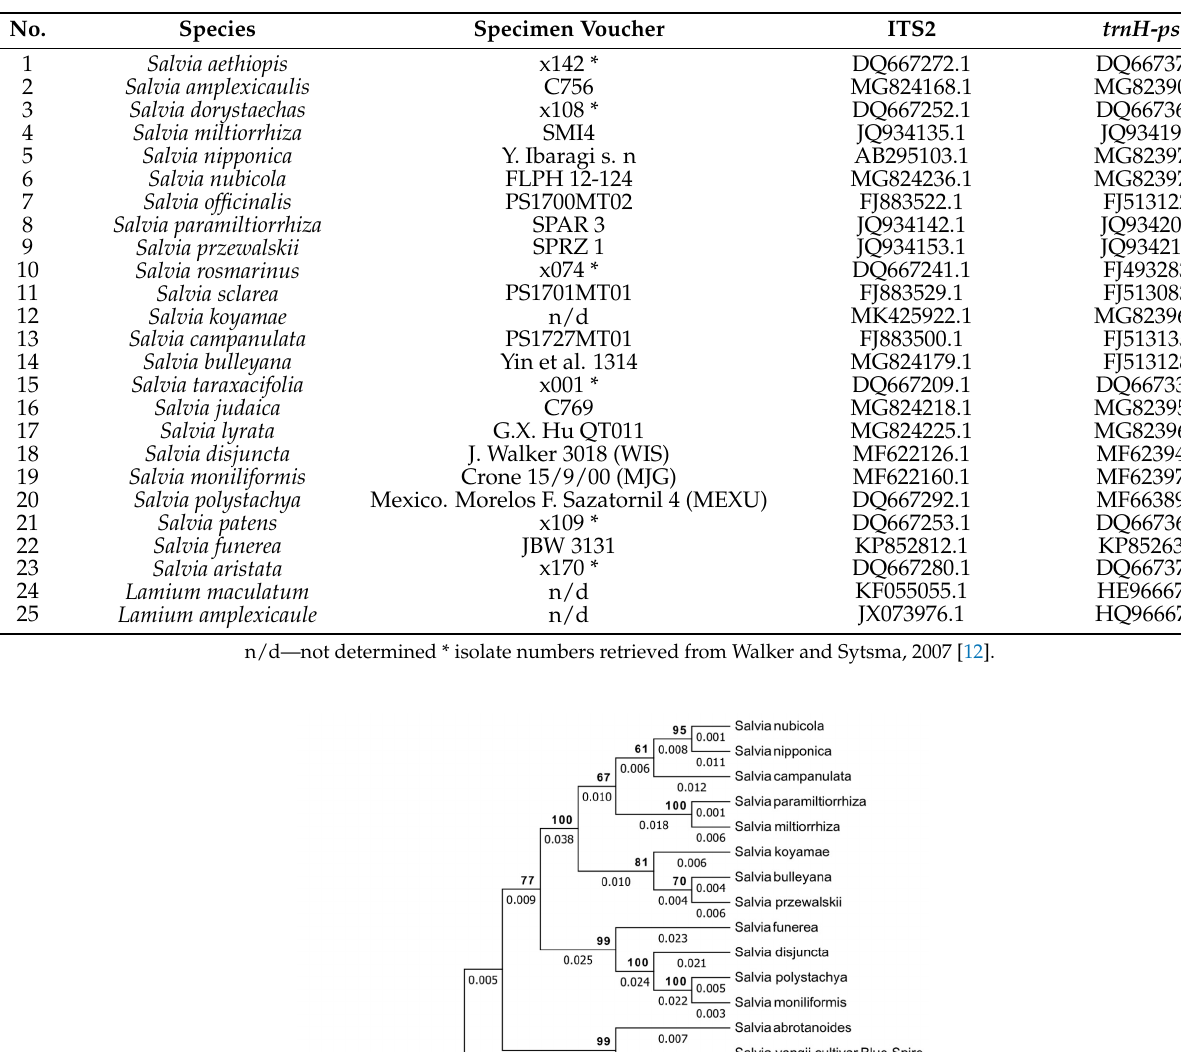
Table 5. DNA sequences of the ITS2 and trnH - psbA regions of 23 Salvia species used for the NJ analysis. Sequences of Lamium maculatum and Lamium amplexicaule were used as an outgroup.